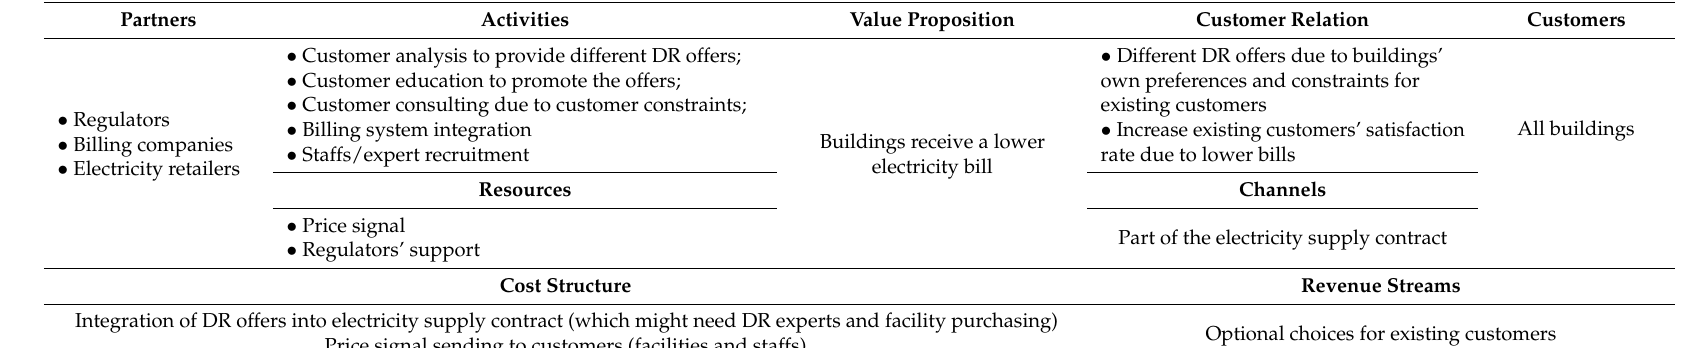
Table 7. Business Model 1—buildings participate in the implicit DR program via retailers.